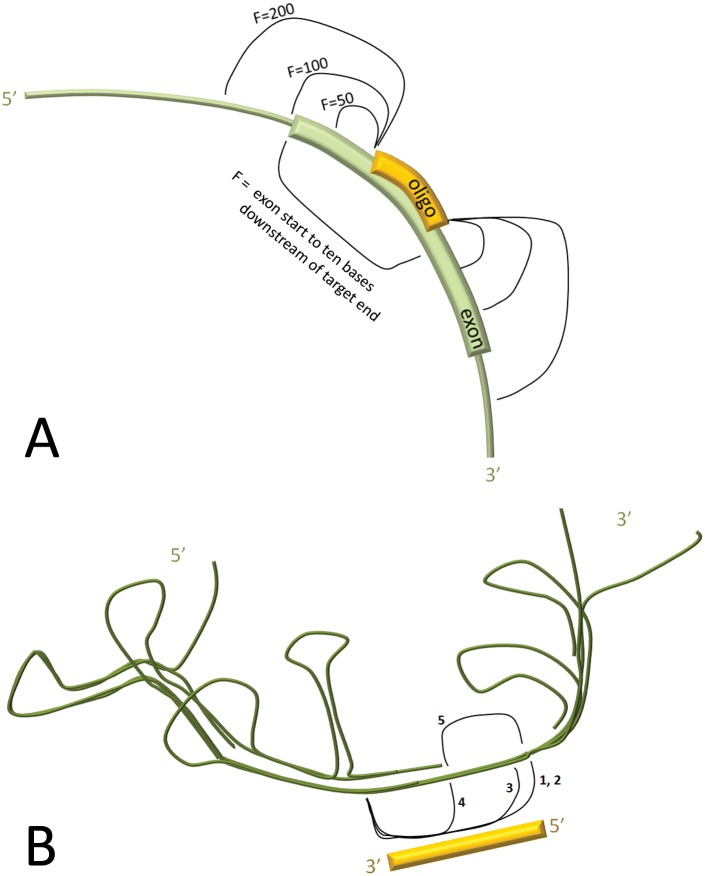
Binding energetics and RNA folding accessibility.(A) The energy (dG) of binding was calculated for the oligo to the target region and flanking regions of various extents: flanks of 50 (dG50), 100 (dG100), or 200 (dG200) bases around the target site, or flanks extending from the 5’ end of the exon to 10 bases downstream of the target 3’ end (dGet+10). (B) Accessibility (the likelihood of bases being unpaired) of the target site within the predicted structure of the folded RNA: (1) target site; (2) target site normalized to oligo length; (3) the 15 bases of the target’s 3’ end; (4) the 8 bases of the target’s 3’ end; (5) the most accessible 8 bases of the target site.